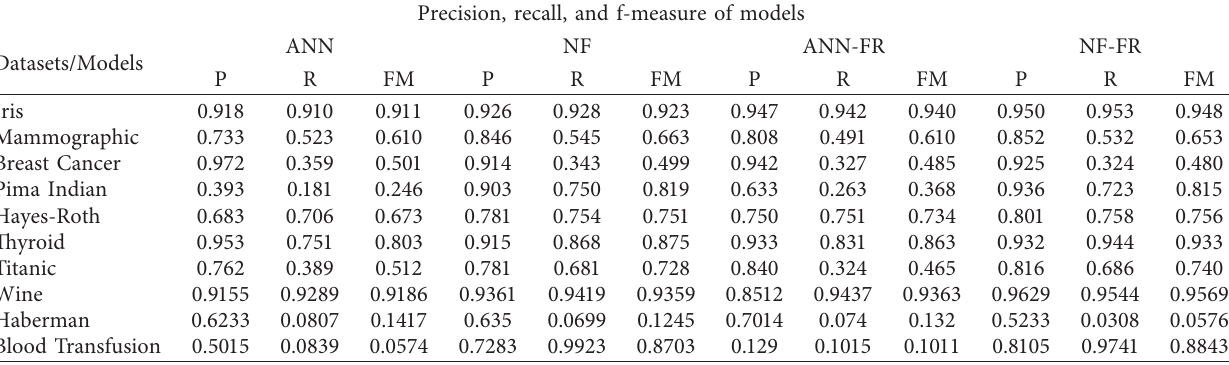
Table 3: Comparison of different performance parameters (precision, recall, and f-measure) of ANN, NF, ANN-FR, and NF-FR models. Precision, recall, and f-measure of models Datasets/Models